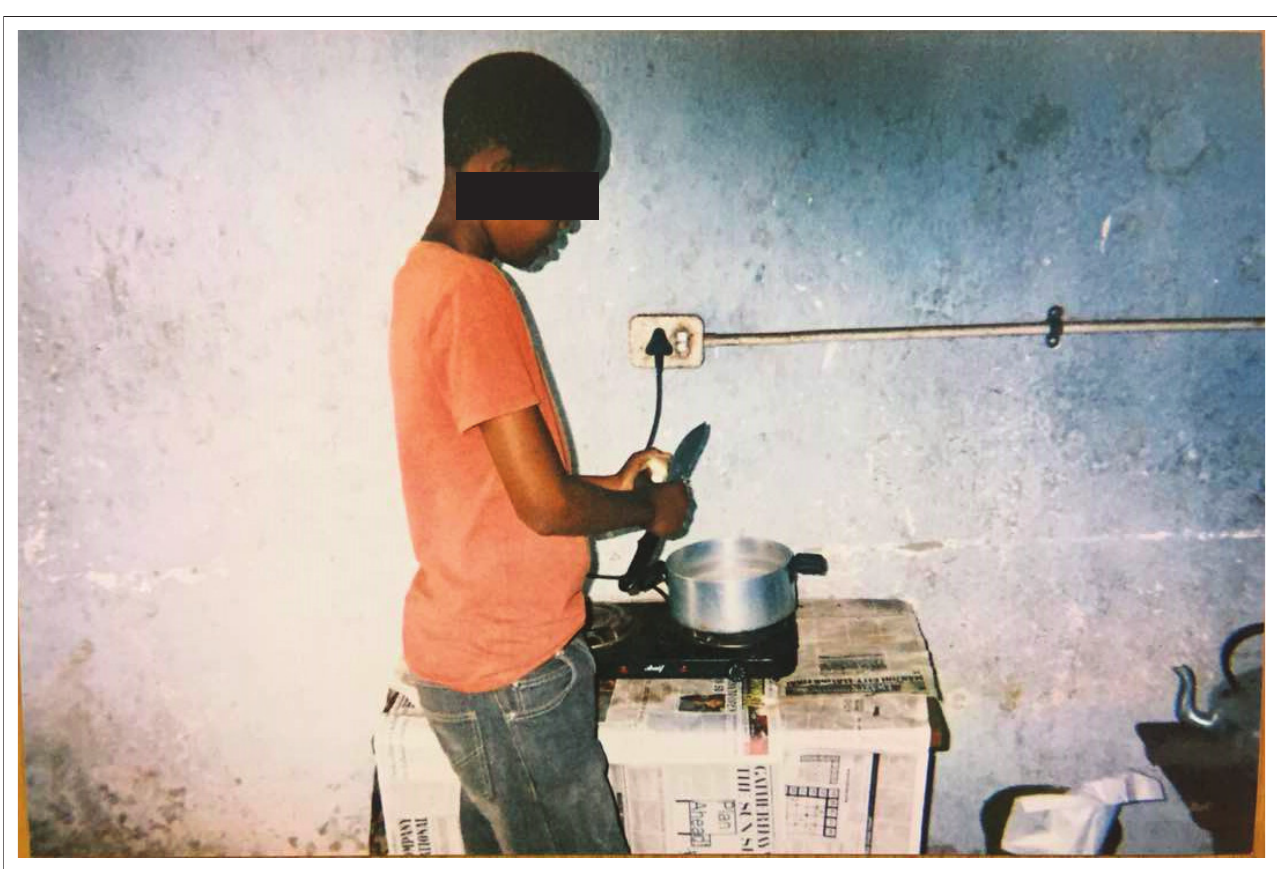
FIGURE 2: From the picture we can see Ngwemash cooking a meal for his family, which consisted of his very old grandmother and siblings aged between 4 and 9 years. Ngwemash provided this picture to illustrate his